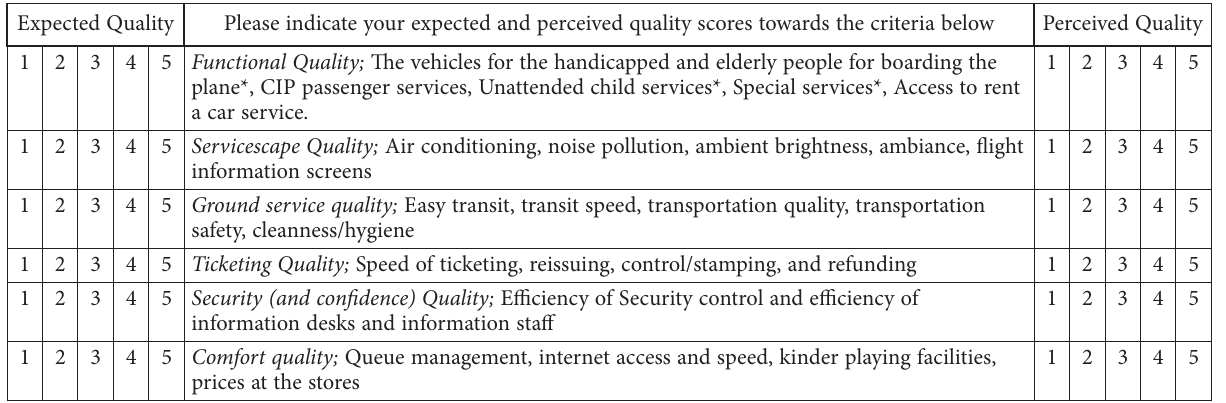
Table 1. Assessment of ASQ quality gap Expected Quality Please indicate your expected and perceived quality scores towards the criteria below Perceived